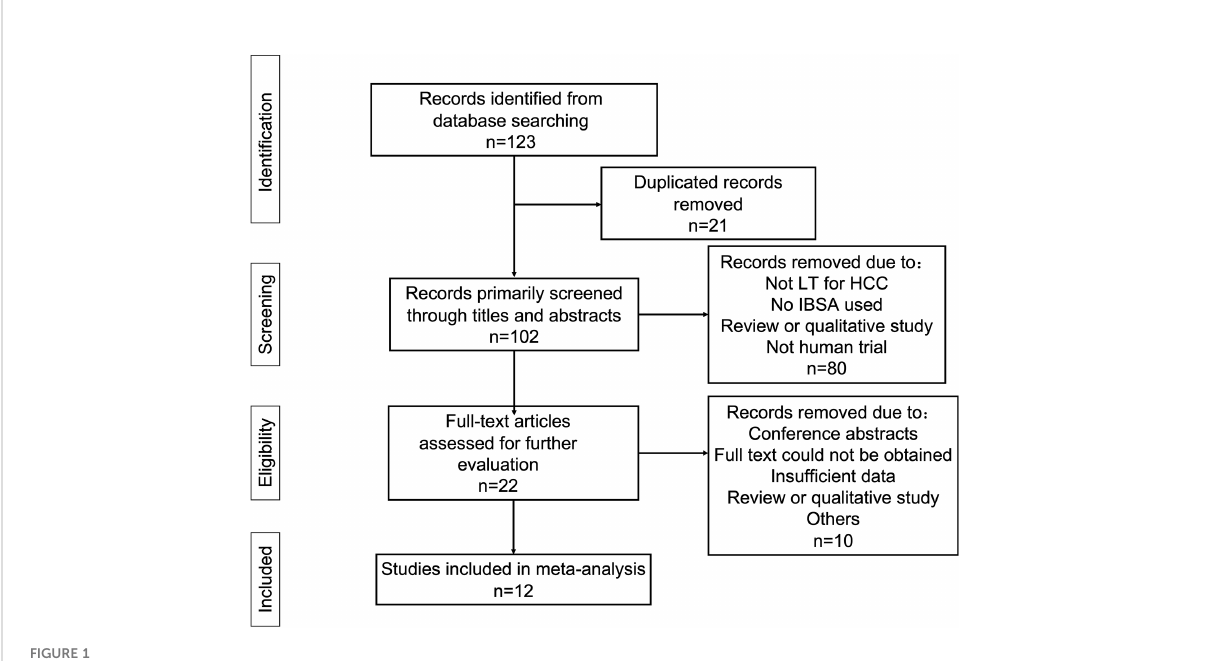
FIGURE 1 Flow diagram of the selection and screening process for eligible studies.